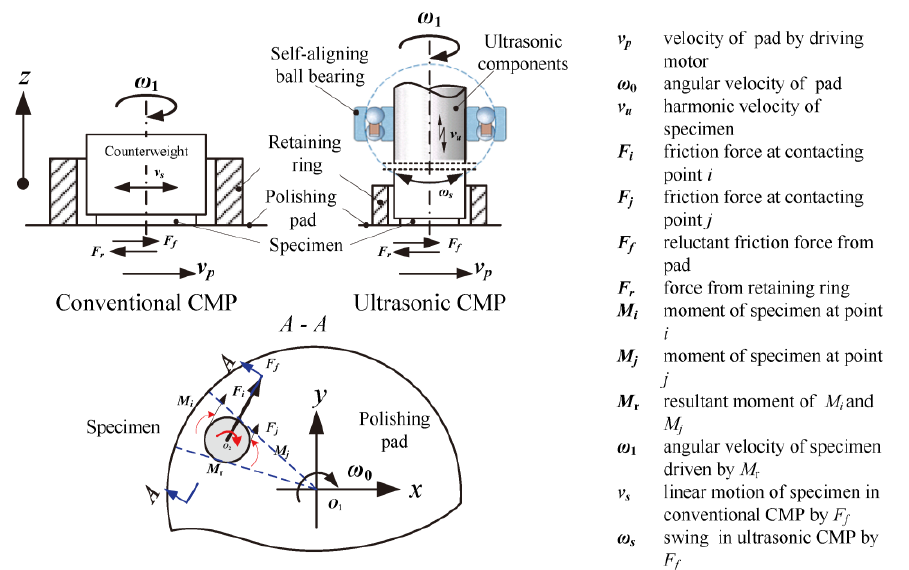
Figure 1. Dynamical schematic diagram of ultrasonic chemical mechanical polishing (CMP) compared with conventional CMP.